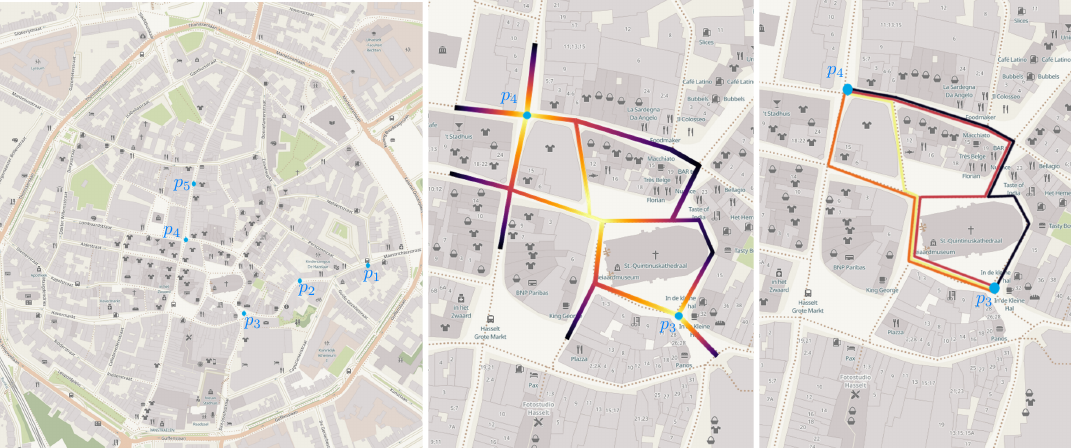
Figure 11. An illustration of the “visit probability” between two anchor points for a pedestrian on a street network in the city of Hasselt. The left most map shows the measured data points during the walk. The map in the middle focuses on two measured points and the spatial projection of the one-dimensional prism between them, colored with visit probabilities. The rightmost figure shows the paths that could be taken and how probable they are in a color gradient, with bright yellow being the most probable and dark blue the least